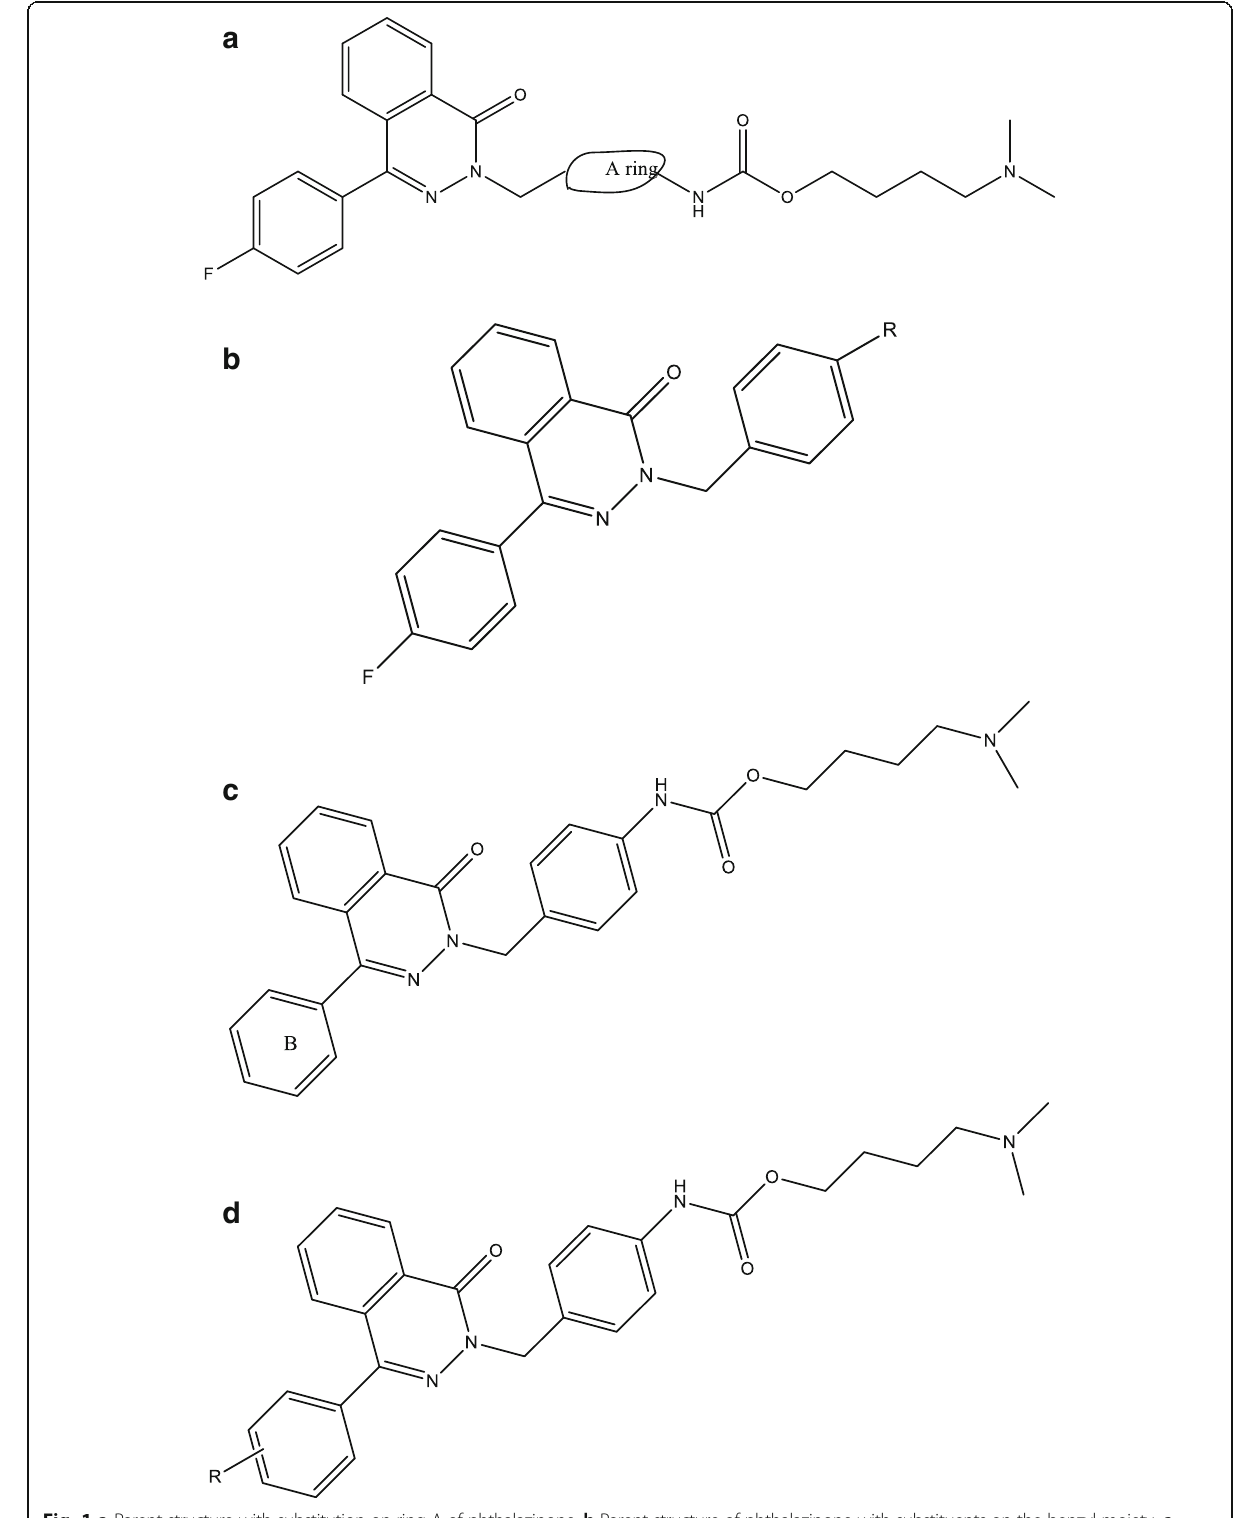
Fig. 1 a Parent structure with substitution on ring A of phthalazinone. b Parent structure of phthalazinone with substituents on the benzyl moiety. c Parent structure of phthalazinone with substitution of B ring of phthalazin core. d Parent structure of phthalazinone with a substituent on phenyl